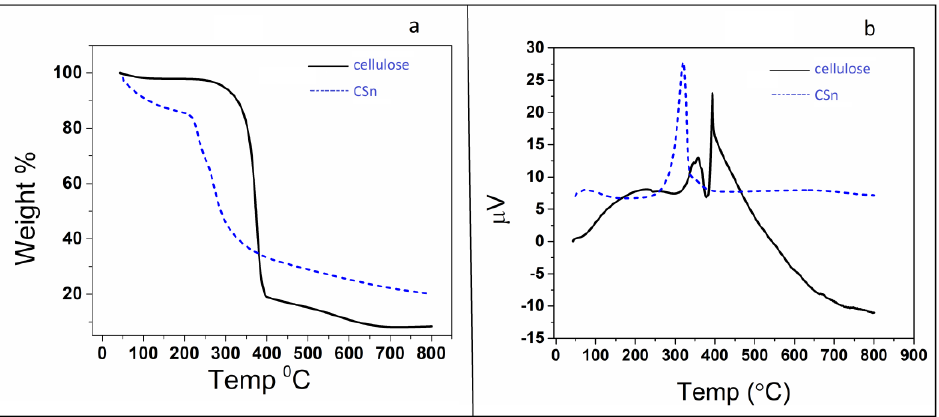
Figure 3. ( a ) TGA curve and ( b ) DTA Curve.